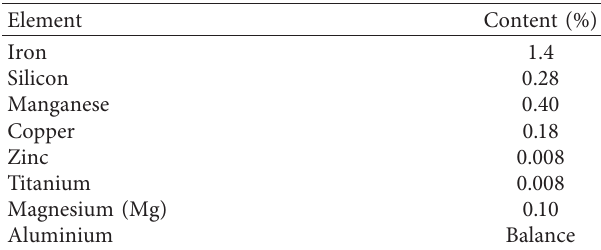
Table 1: Chemical composition of